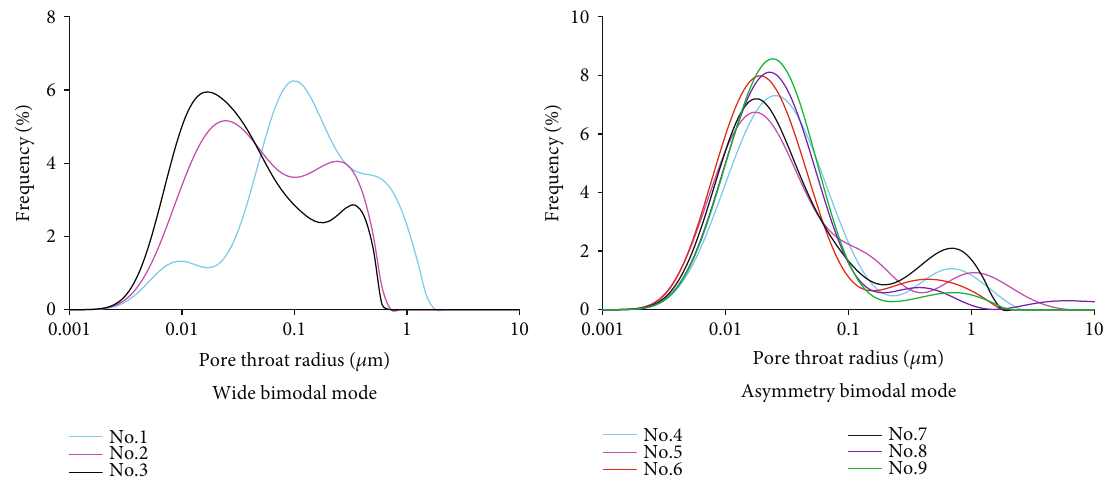
Figure 1: Pore throat distribution characteristics of reservoirs with di ff erent pore throat structure